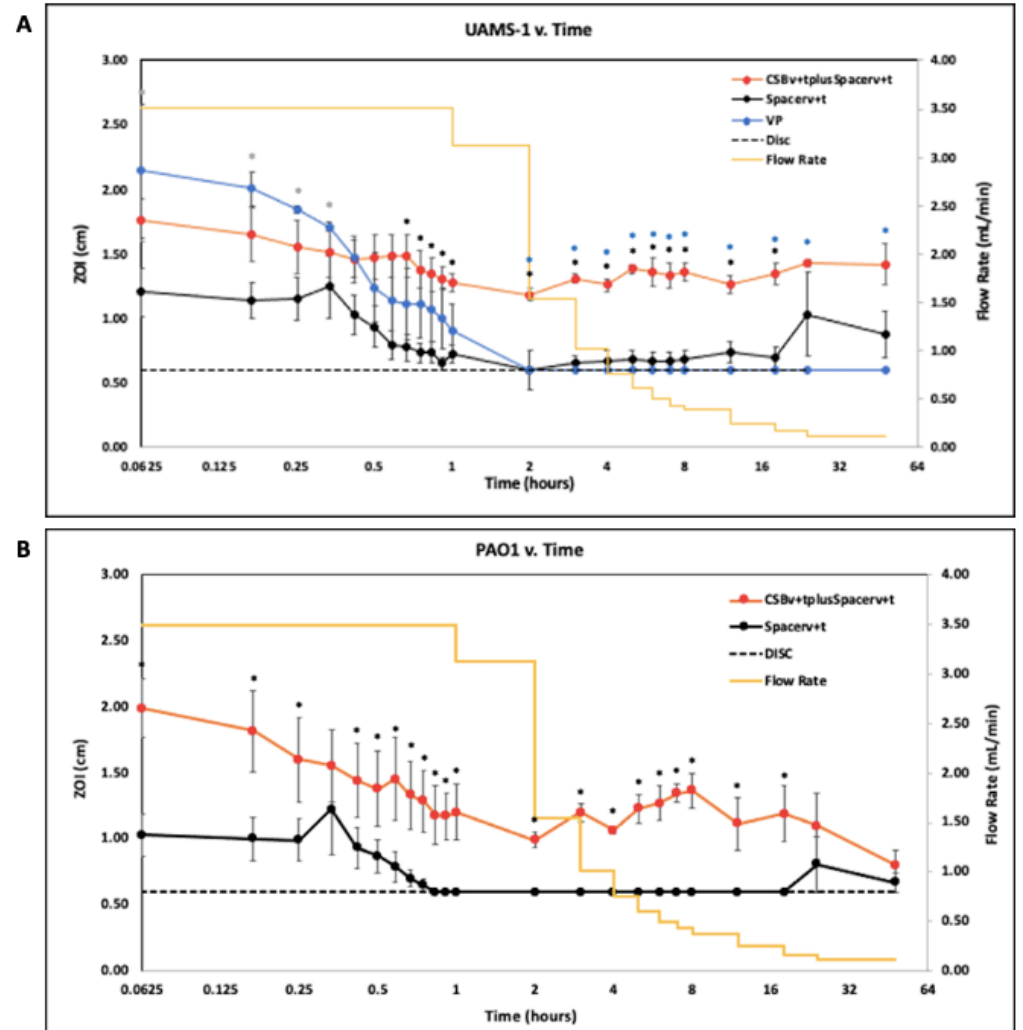
Figure 6. ( A ). Potency of drainage effluent from the reactor measured as the ZOI of effluent against S. aureus UAMS-1 reported on a Log2 scale for 48 h after flow rates were initiated. The dashed line indicates the diameter of the disc. When the ZOI of the effluent was equivalent to the diameter of the disc, it indicates growth up to the edge of the disc and is assumed there was no antimicrobial potency. (* p < 0.05 for the CSB v+t plusSpacer v+t compared to the Spacer v+t alone, * p < 0.05 for the CSB v+t plusSpacer v+t compared to the VP, and * p < 0.05 for the Spacer v+t alone compared to the VP) N = 3, mean ± SE. ( B ). ZOI of effluent against P. aeruginosa PAO1 reported on a Log2 scale for 48 h after flow rates were initiated. The dashed line indicates the diameter of the disc. N = 3, mean ± SE. (* p < 0.05 for the CSB v+t plusSpacer v+t compared to the Spacer v+t alone).